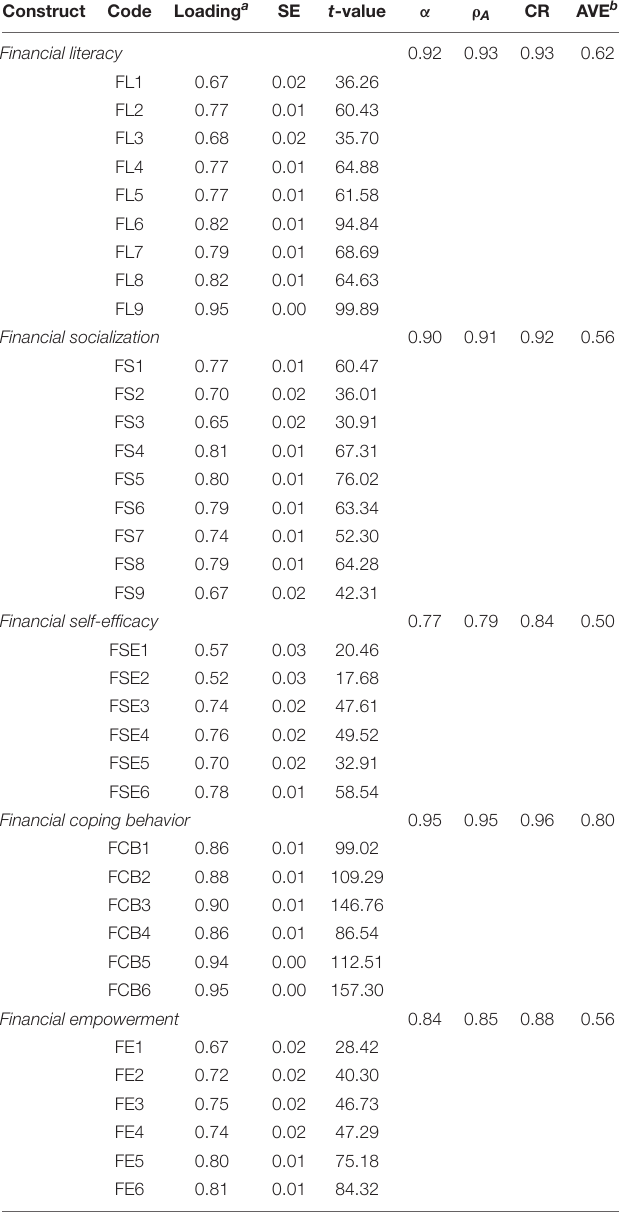
TABLE 1 | Measurement model results: loadings, construct reliability, and convergent validity coefficients. Construct Code Loading a